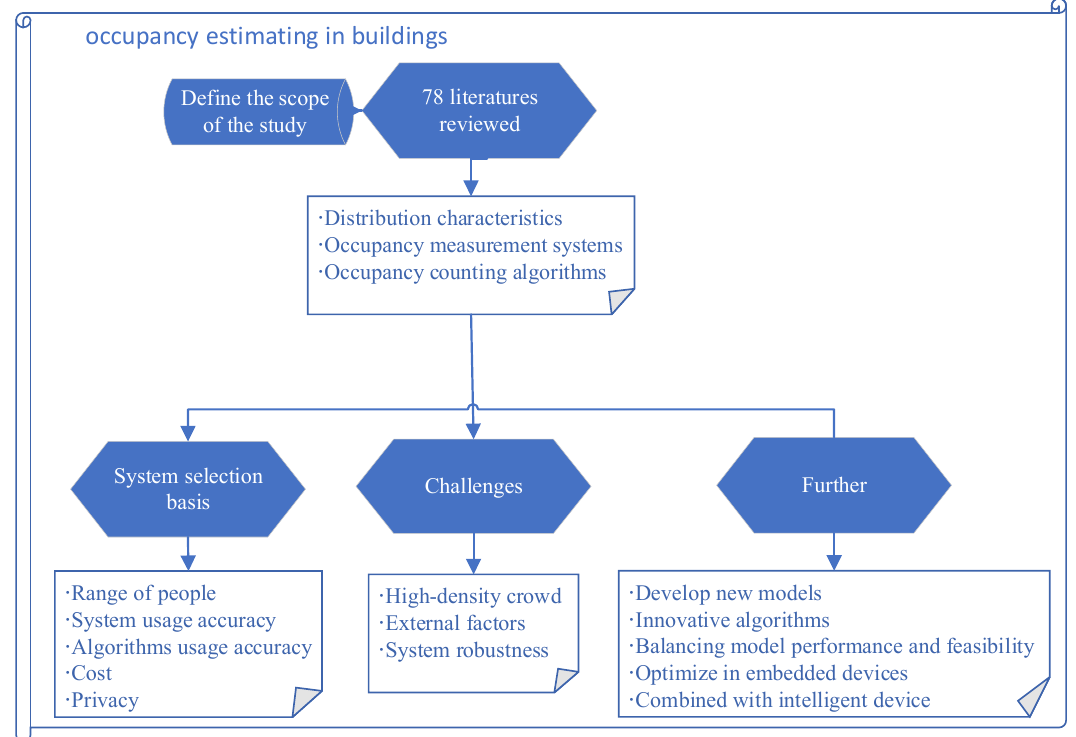
Figure 1. An overview of the